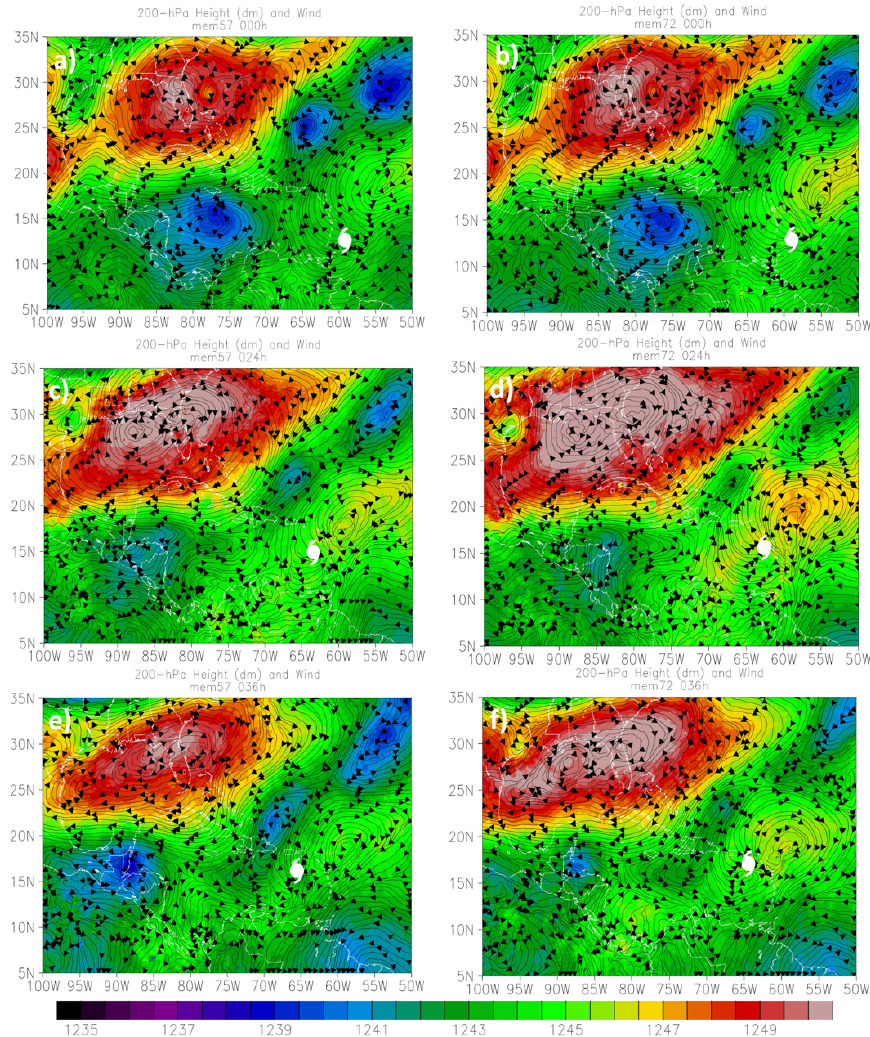
Figure 11. ( a ) 200-hPa height (dm, shaded) and wind (kt, wind barbs, 1 kt = 0.51 m s − 1 ) at 0 h for the weak member. The white hurricane symbol shows the forecast position of Dorian. ( b ) As in ( a ), but for the strong member. ( c ) As in ( a ), but for 24 h. ( d ) As in ( b ), but for 24 h. ( e ) As in ( a ), but for 36 h. ( f ) As in ( b ), but for 36 h.